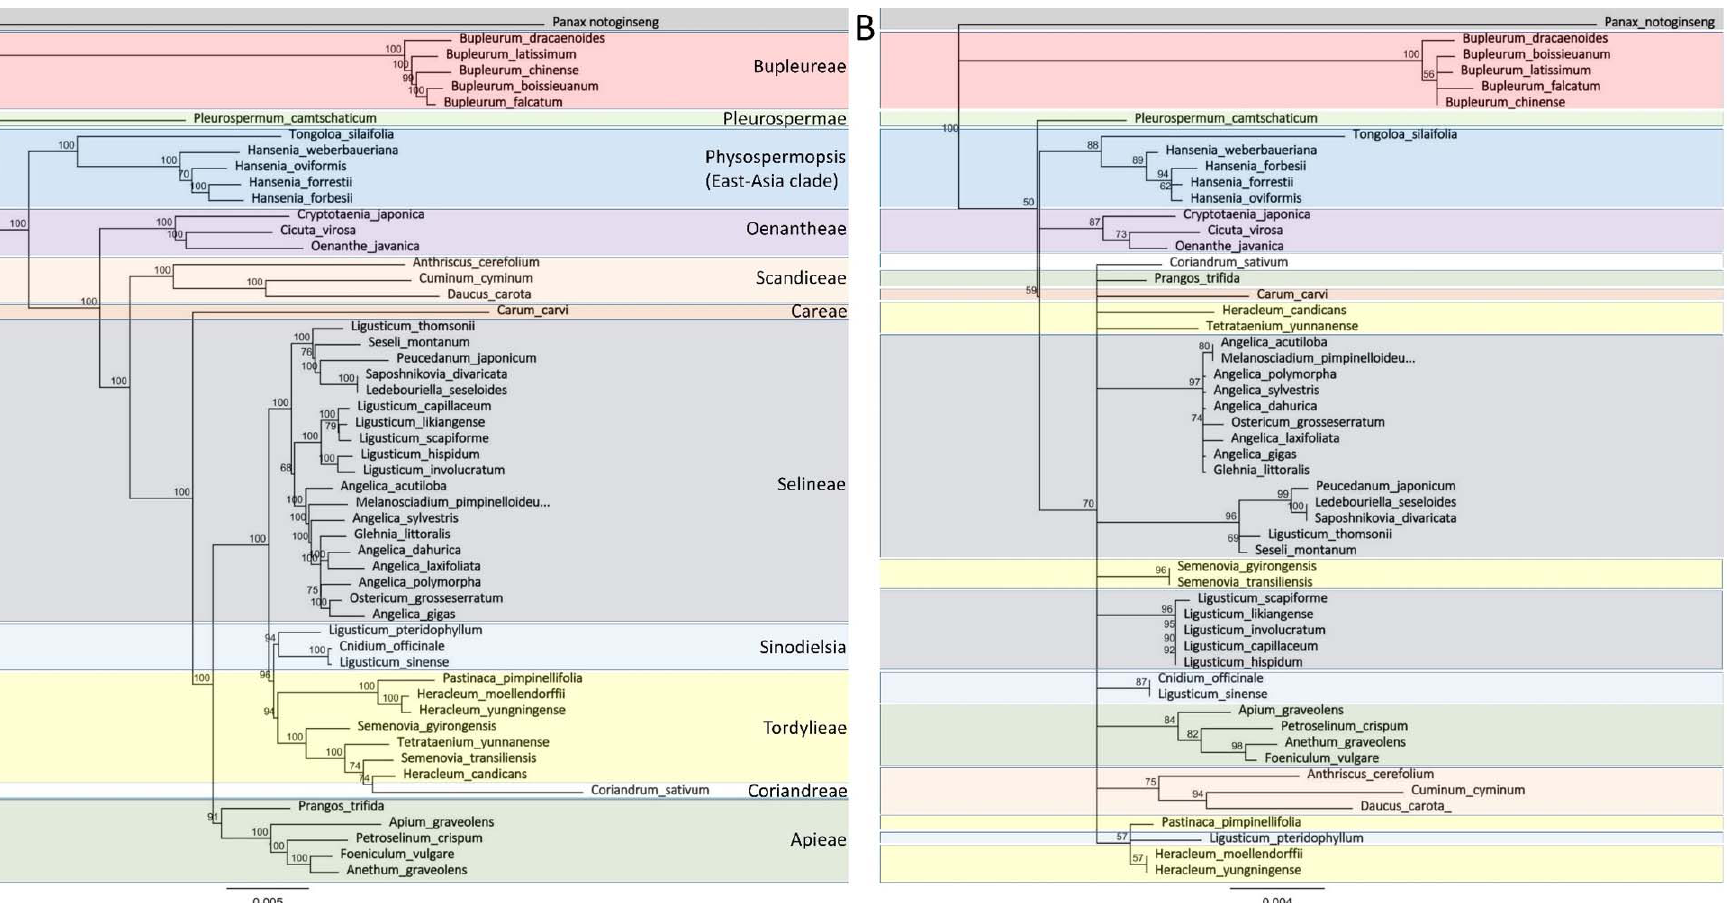
Figure 4. Phylogenetic relationships inferred from 53 species of the Apiaceae family by using Panax notoginseng (Arialaceae) as an outgroup; each clade is highlighted with a different color. ( A ) The 54 plastid genomes were retrieved from GenBank (Table S1) and aligned using MAFFT v7.450 [150] under default parameters; Geneious prime (Biomatters, Inc., San Diego, CA, USA) was used to reconstruct the phylogenetic relationships based on the Neighbor-Joining (NJ) method, and 1000 bootstrap replicates. ( B ) rbcL sequences were extracted from the 54 plastid genomes analyzed in Panel A and aligned using MAFFT v7.450 [150]; the phylogenetic relationships based on the Neighbor-Joining (NJ) method and 1000 bootstrap replicates were reconstructed using Geneious prime (Biomatters, Inc., San Diego, CA, USA) under default parameters.